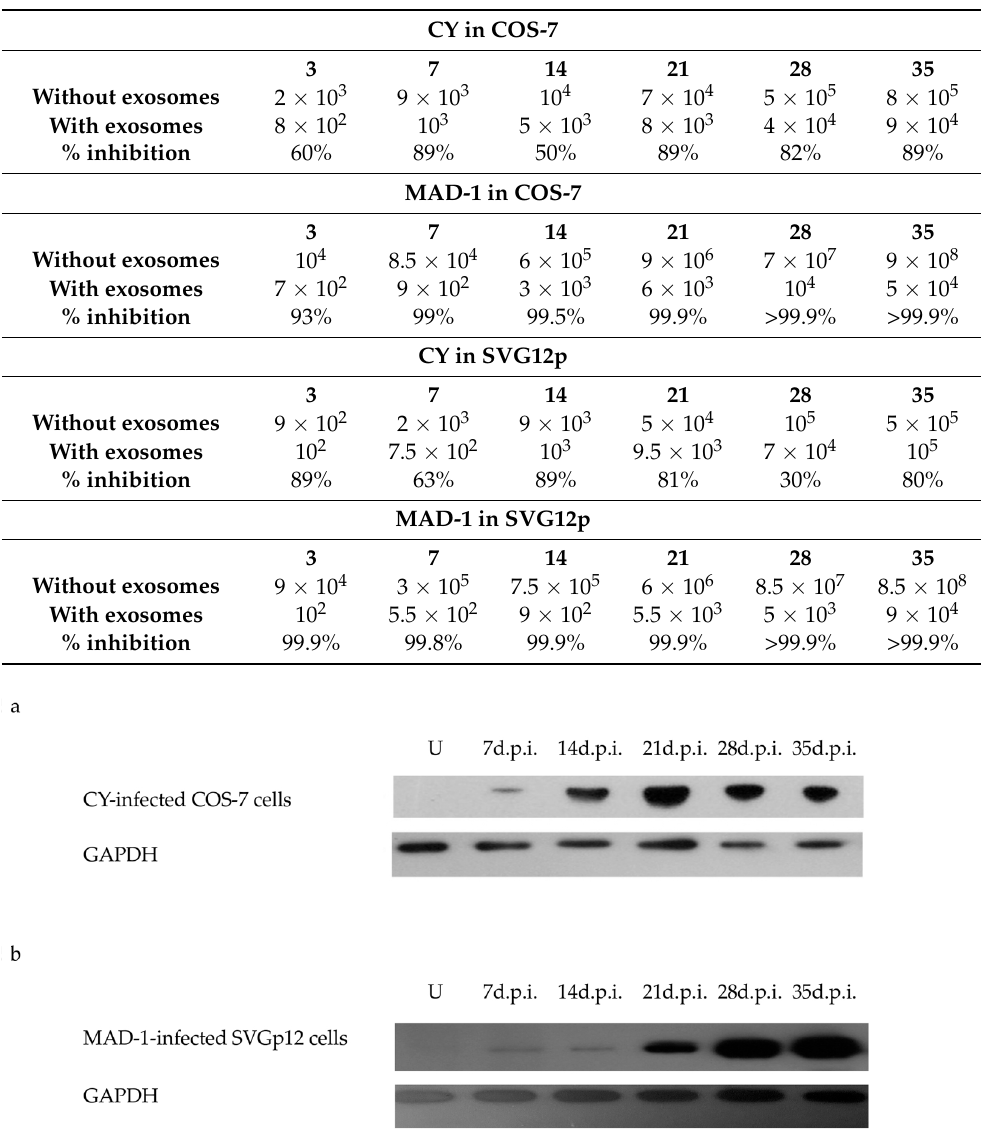
Table 1. Differences in viral replication with and without exosomes as a percentage of inhibition.